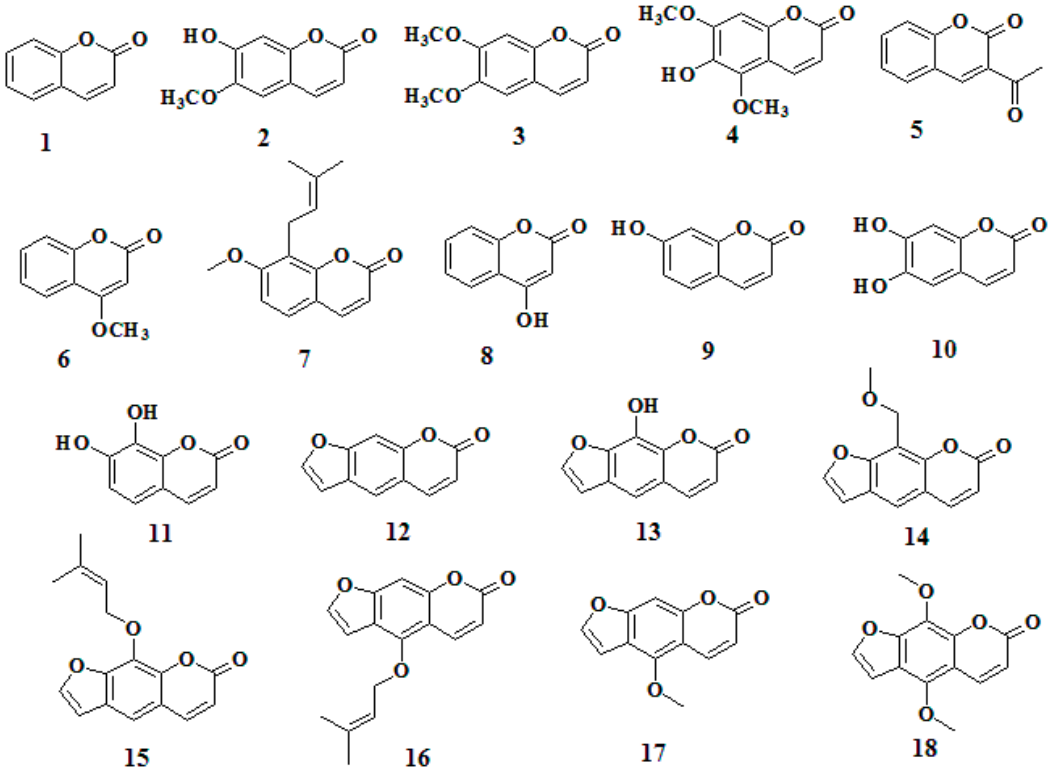
Figure 1. The chemical structures of the studied coumarins. Table 1. The antibacterial activity of coumarins against R. solanacearum .